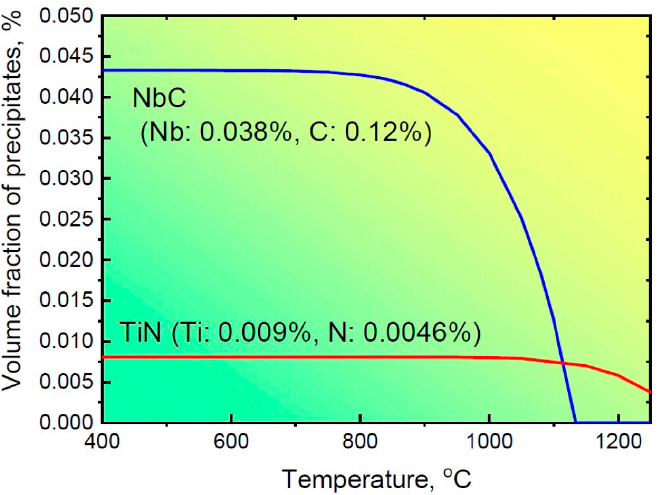
Figure 8. The precipitation of NbC and TiN particles changed with different temperatures for steel S2.